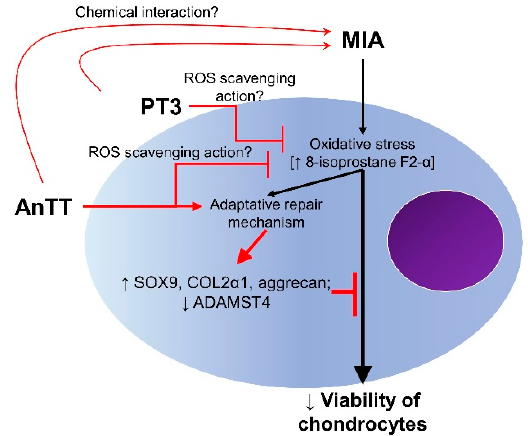
Figure 6. Proposed mechanism of action of tocotrienols on chondrocytes. Both AnTT and PT3 suppress oxidative stress induced by MIA. AnTT also enhances the self-repair mechanism and anabolic activities of chondrocytes exposed to MIA. Abbreviations: ↑ , cause or induce; (cid:124) , inhibit; AnTT, annatto tocotrienols; COL2 α 1, collagen type II α 1; PT3, palm tocotrienol-rich fraction; SOX9, sex-determining region Y box protein